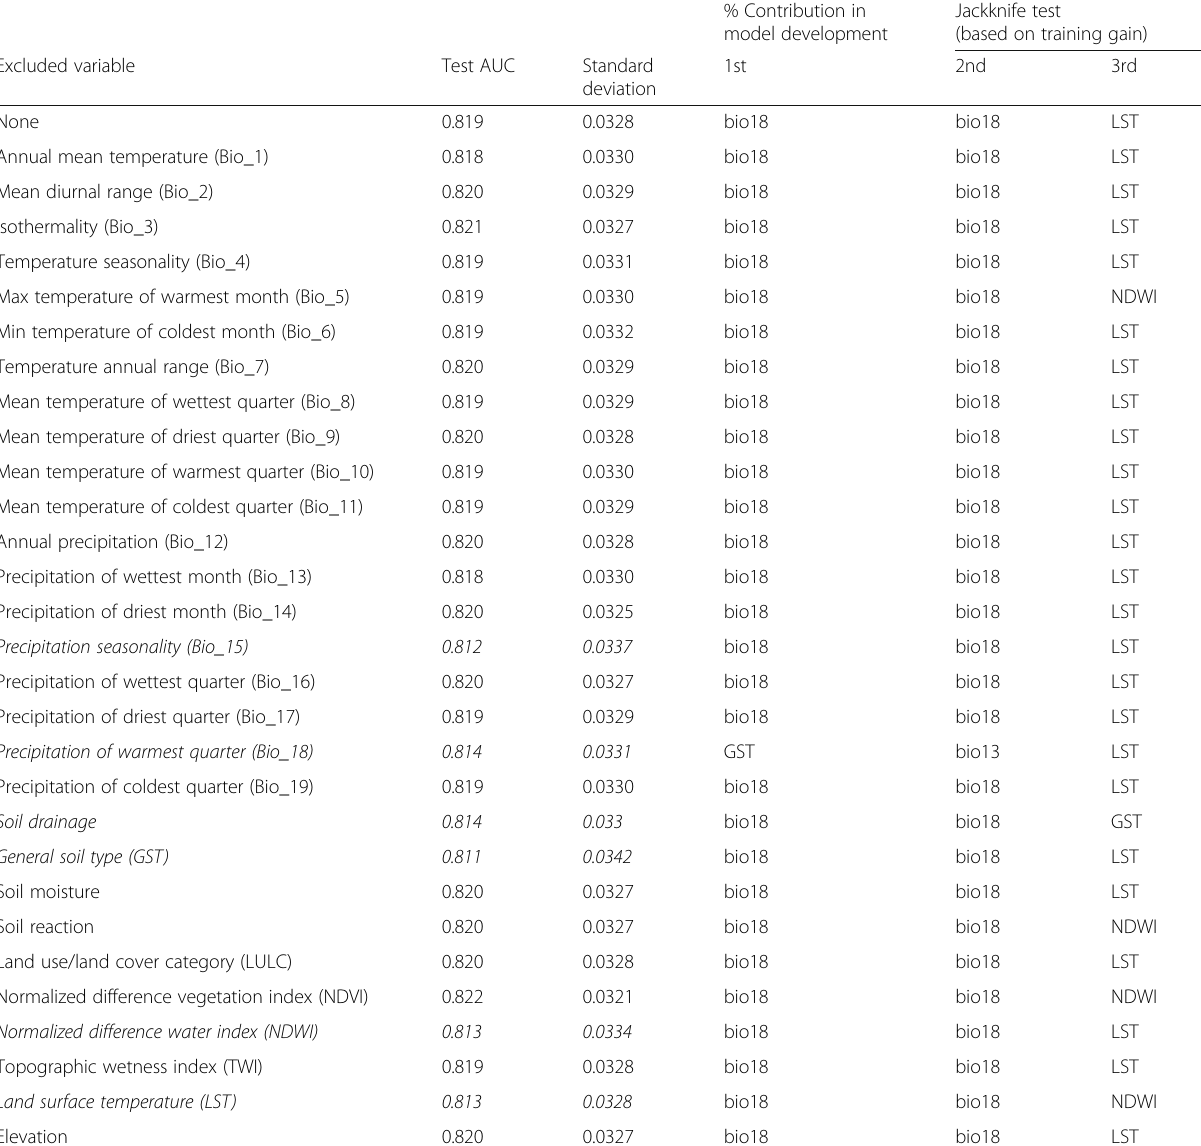
Table 2 Results of the 30 runs of the models with individual variables excluded in turn